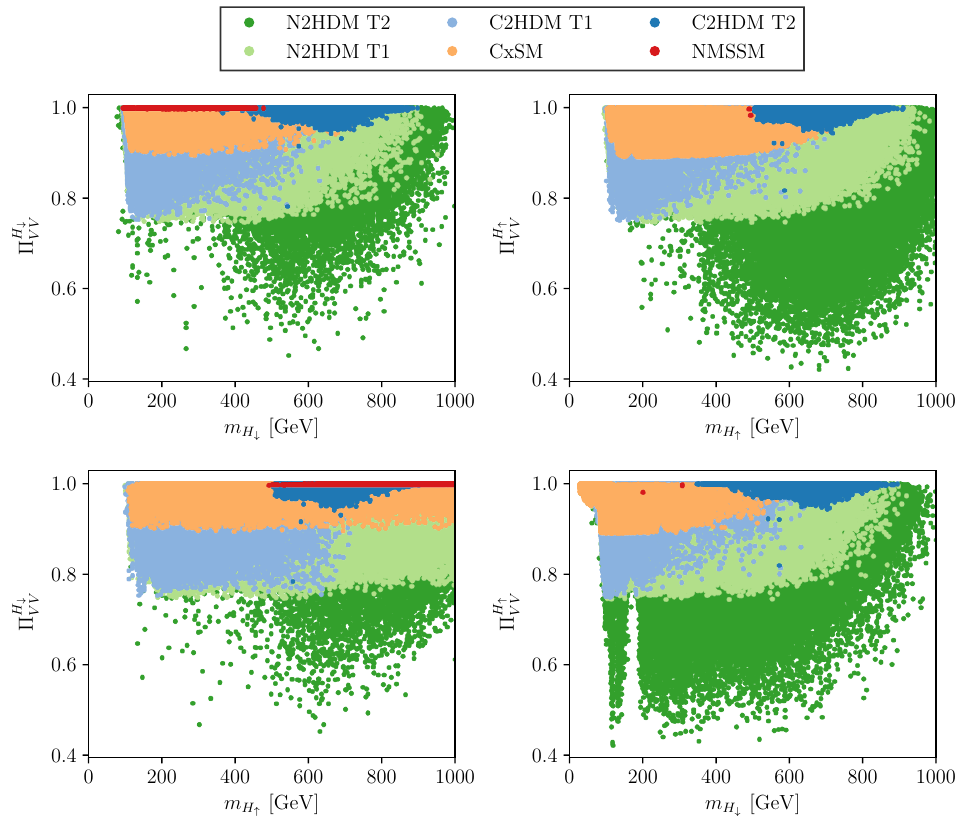
Figure 12 . The partial gauge boson sum (cid:5) (2) assuming the only additionally discovered Higgs V V boson is H # (left) or H " (right) as a function of their respective mass (upper) and as a function of the mass of the non-discovered Higgs boson, respectively, (lower), for the CxSM (yellow), the type I N2HDM (fair green) and C2DHM (fair blue), the type II N2HDM (dark green) and C2HDM (dark blue) and the NMSSM